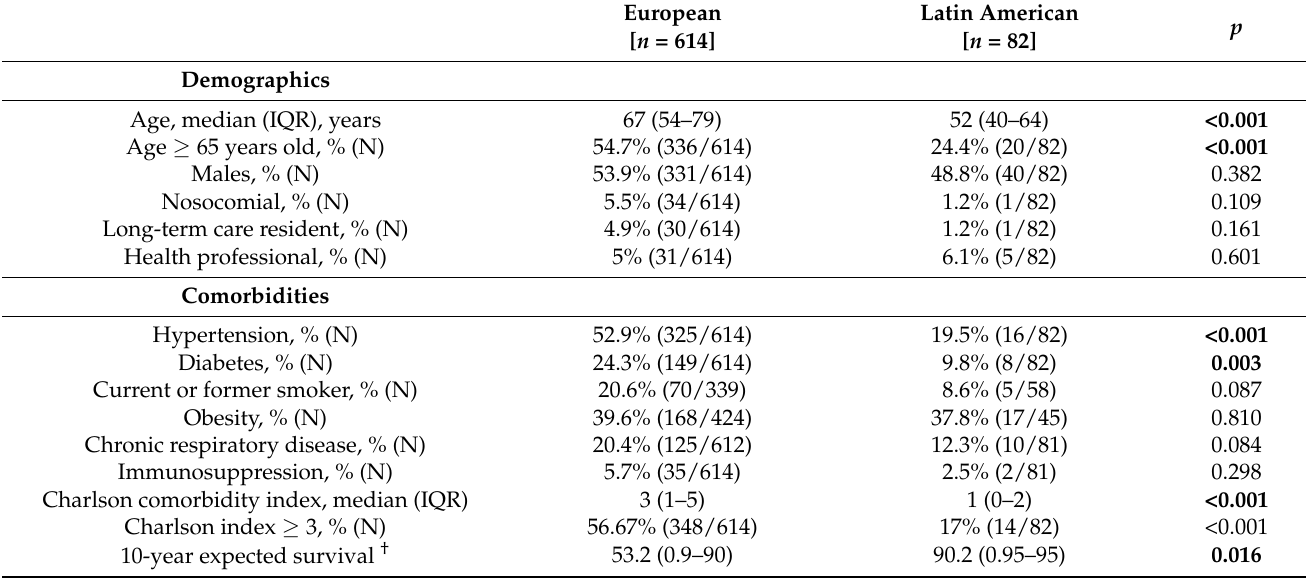
Table 1. Basal demographic characteristics, comorbidities, and clinical presentation by